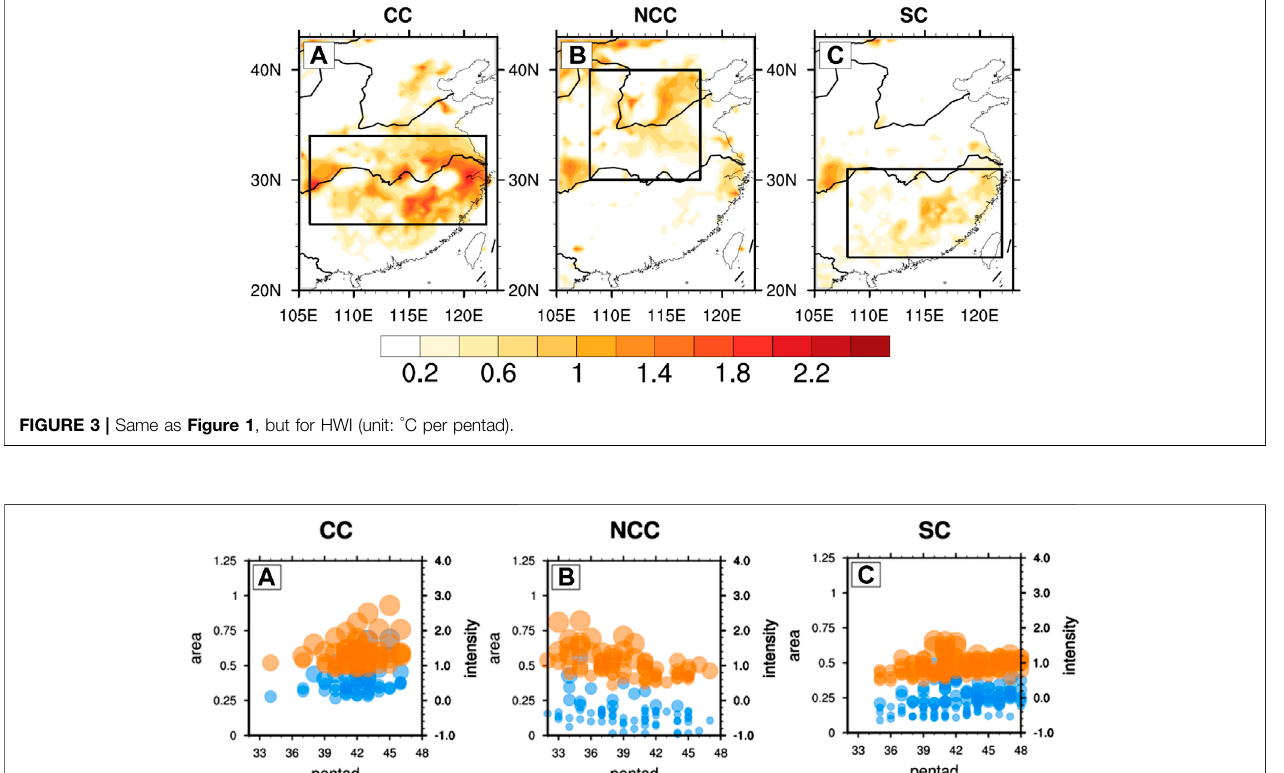
Frontiers in Earth Science |